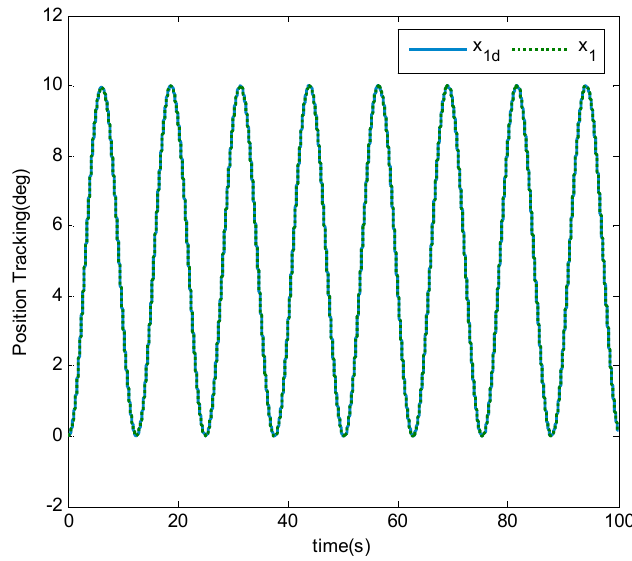
Figure 3. The position tracking of ARCBF as ε = 1 × 10 − 6 .